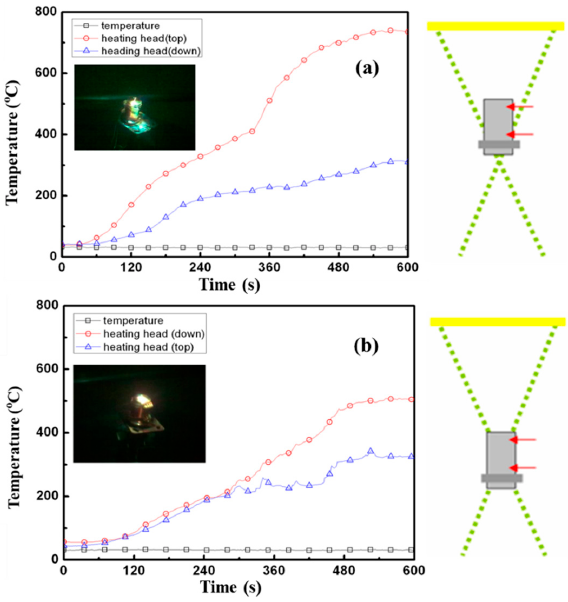
Figure 3. Heating temperature diagram with different focus location of the heating head. ( a ) Sunlight cover the heating head ( b ) Sunlight focused on top of the heating head.